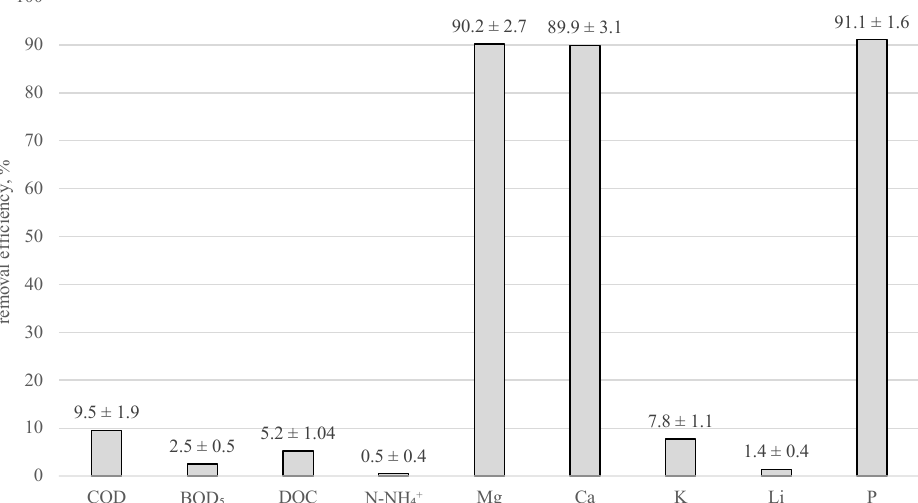
Figure 2. Removal efficiency of selected contaminants in the analyzed sample during struvite precipitation. An analysis of the precipitates performed with a scanning electron microscope (Figure 3) confirmed that crystalline forms of struvite were separated from the solution of the liquid fraction of the digestate as a result of chemical precipitation. The pictures show a large amount of organic matter and a large number of microorganisms.